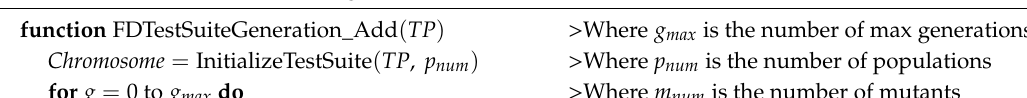
Algorithm 3. Fault-detection test-suite generation (additional test suite).